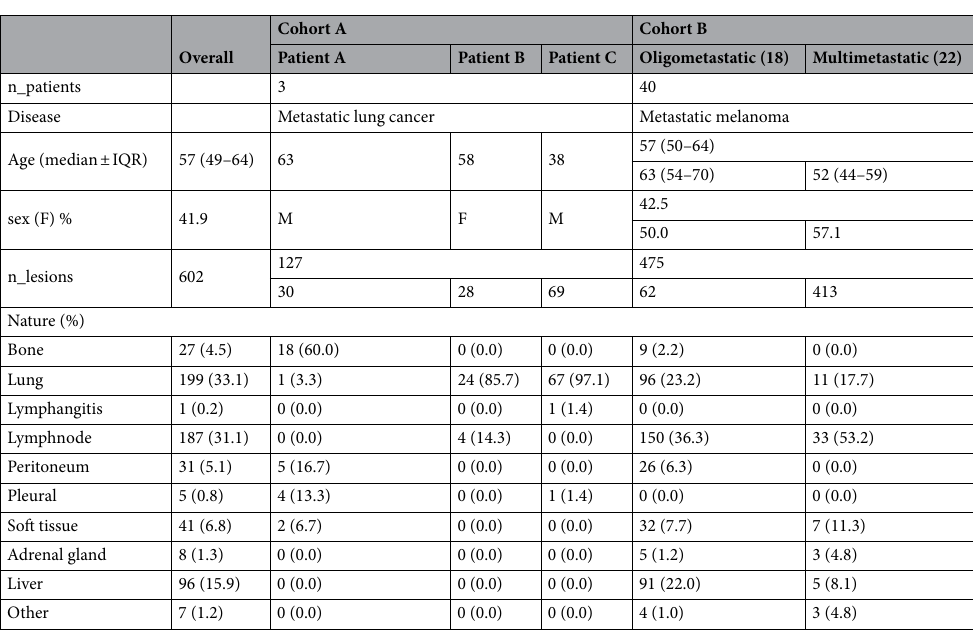
Table 1. Description of the study population and of the lesion distribution across cohorts, patients and metastatic